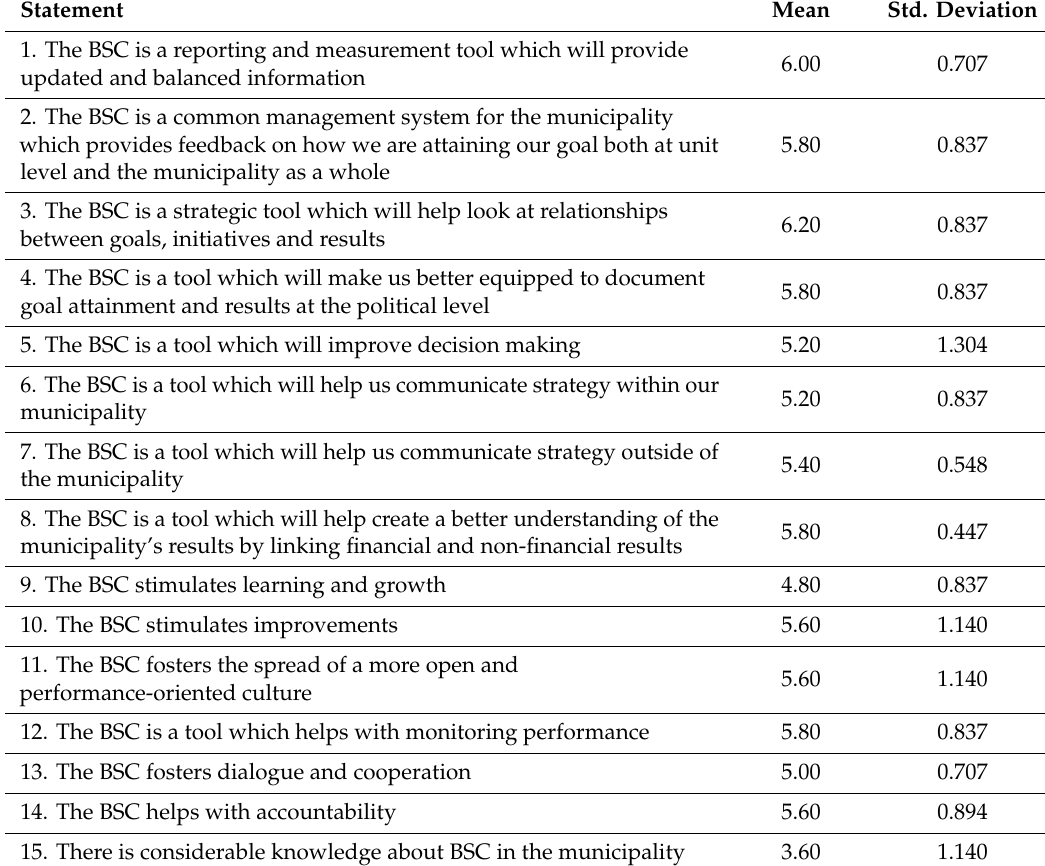
Table 12. Reasons why the municipality is planning to adopt the BSC (N = 5) [Scale: